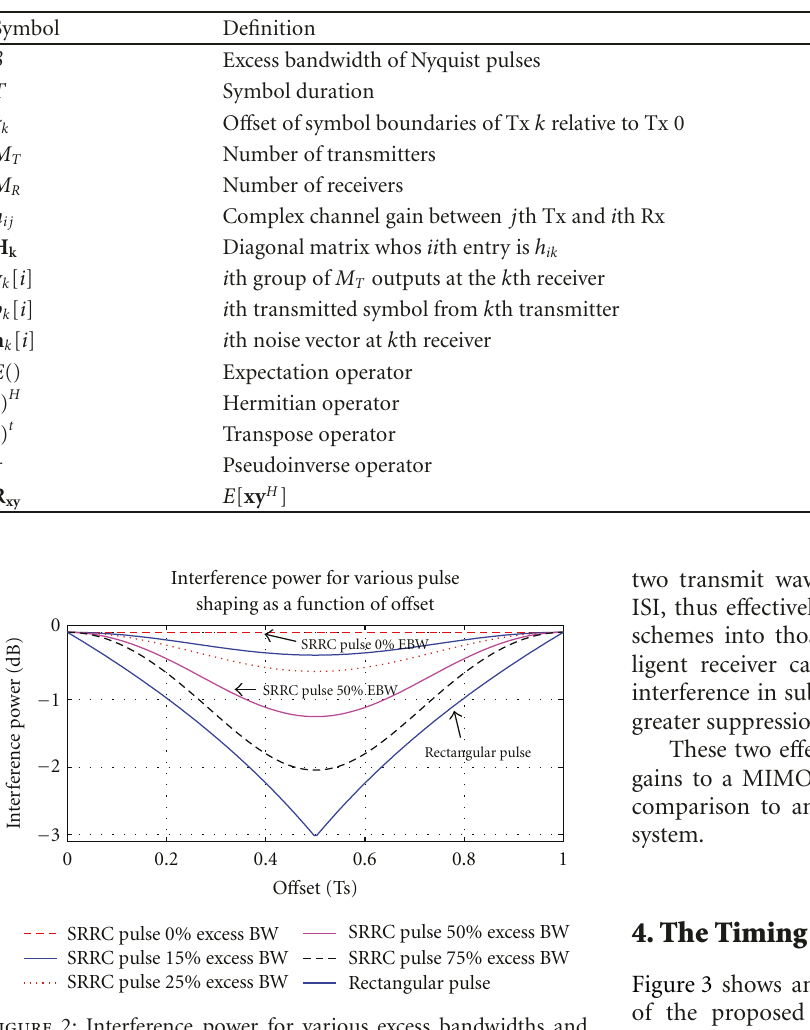
Figure 2: Interference power for various excess bandwidths and o ff sets. Note: no gain at 0 excess